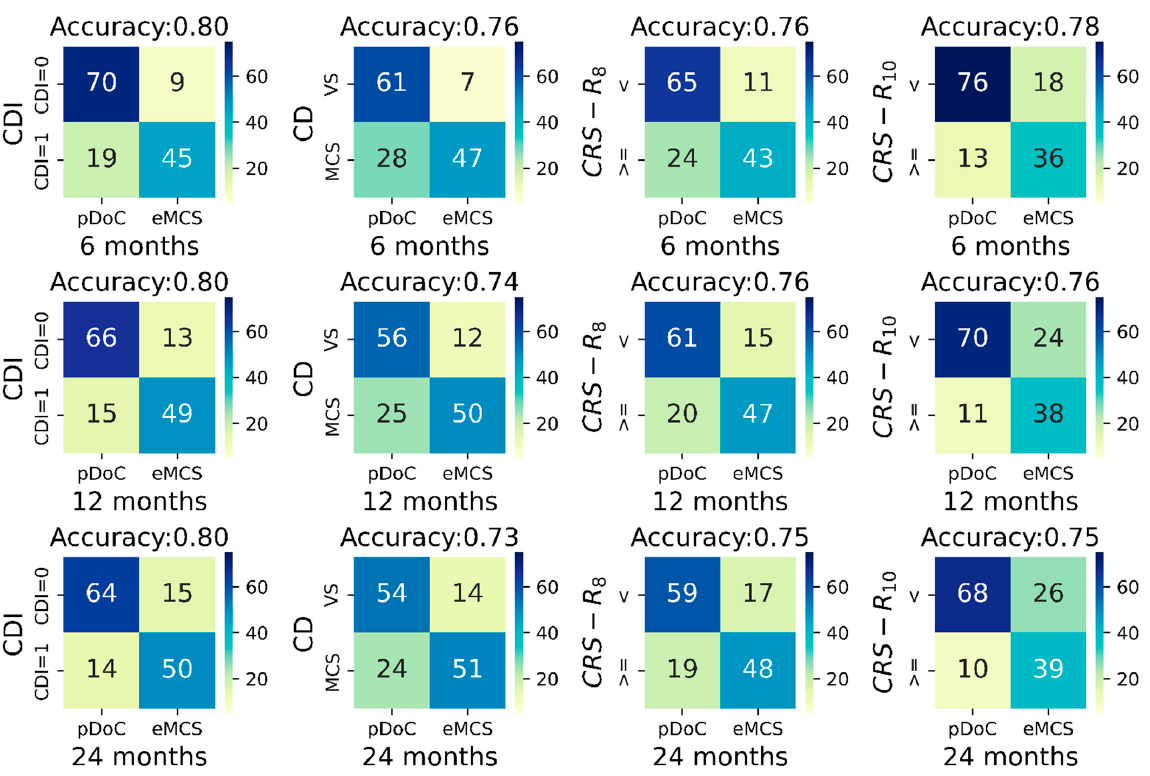
Figure 1. Contingency tables between CDI, clinical diagnosis at study entry, CRS-R 8 , CRS-R 10 (columns left to right) with respectively the outcome at 6 months (top row), at 12 months (middle row), and at 24 months (bottom row). Each contingency table has on the x-axis the outcome set as presence/absence of a pDoC at the different outcome timing, and on the y-axis patients with CDI = 1 or CDI = 0 (first column), patients in VS or in MCS (second column), and patients with CRS-R smaller than (<) or greater/equal to (>=) the indicated threshold (third and fourth columns). Colors indicate the relative amount of patients within each cell; the color gradient is reported within the color bar on the right of each table. Abbreviations: CD, clinical diagnosis; CDI, Consciousness Domain Index; CRS-R, Coma Recovery Scale-Revised; eMCS, emergence from the minimally conscious state; pDoC, prolonged disorder of consciousness; VS, vegetative